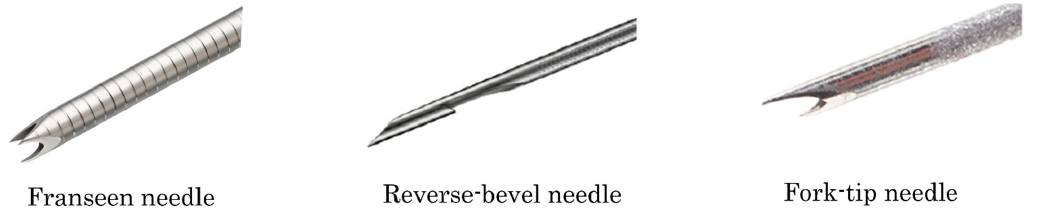
Figure 1. The shapes of the needles. ( Left ) Franseen needle. ( Center ): Reverse-bevel needle. ( Right ) Fork-tip needle. Clinical trials have evaluated the diagnostic rate of EUS-FNA only, EUS-FNB only, and both EUS-FNA and EUS-FNB [58–62]. Most trials that evaluated the diagnostic rate of EUS-FNA only compared EUS-FNA with various biopsy methods. Most studies re- ported that FNB showed a superior diagnostic rate to FNA, because FNB achieved ade- quate sampling. The diagnostic rate of EUS-FNA for lesions of any size, <20 mm, and ≥ 20 mm was 34.8–82%, 39.1–83.3%, and 33.3–91.6%, respectively. On the other hand, the diagnostic rate of EUS-FNB for lesions of any size, <20 mm, and ≥ 20 mm was 64.3–94.1%, 46.7–100%, and